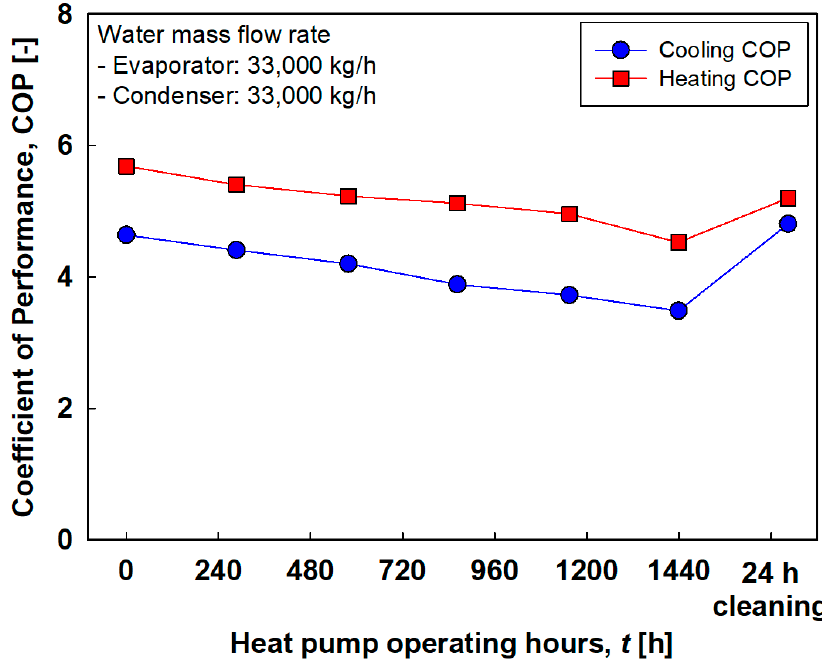
Figure 13. Variation of heat pump capacity and compressor power consumption according to heat pump operating hours.